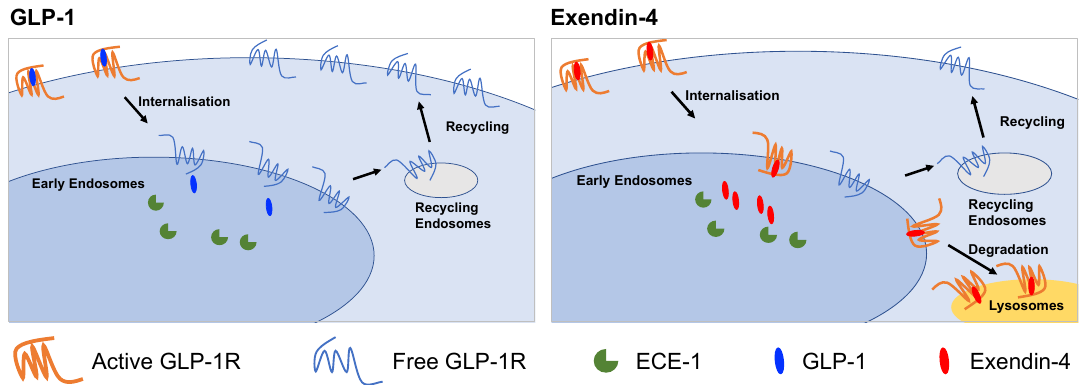
Figure 6. Graphical summary of differences between GLP-1R trafficking induced by GLP-1 and exendin-4. GLP-1 favours GLP-1R recycling to the plasma membrane whereas exendin-4 promotes lyosomal